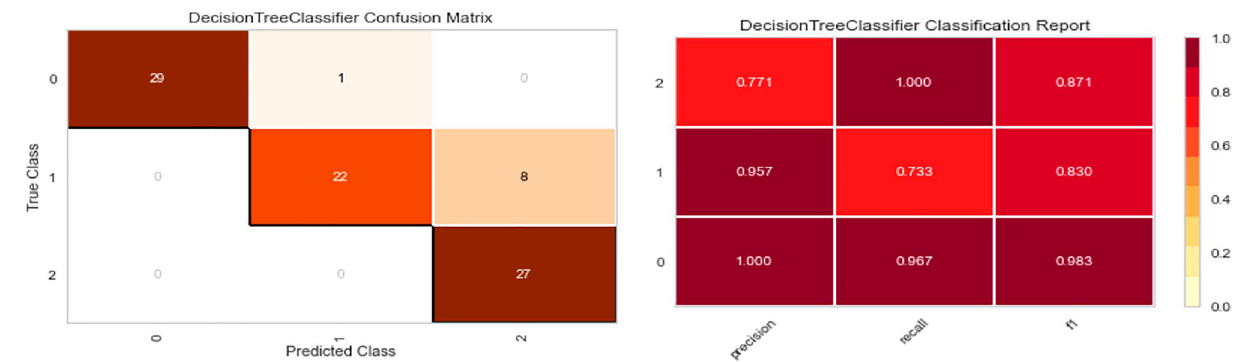
Figure 11. Matrix confusion and Report Classification of Decision Tree.